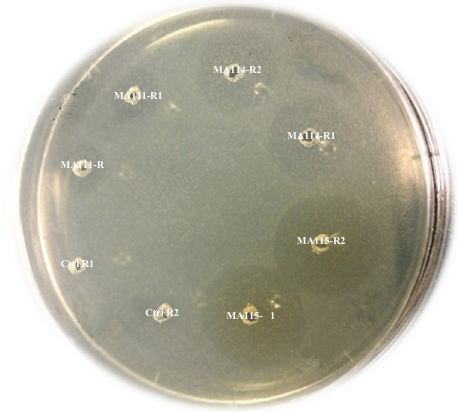
Figure 1: Inhibition zones of CFSn extracted from three LAB strains on the surface of MH agar plate layered with L. monocytogenes using the agar well di ff usion assay after incubation at 37°C for 24 h. The CFSn of three LAB isolates with anti - listerial activity: isolate MA115, isolate MA114, and isolate MA111, and sterilized MRS broth as control ( Ctrl ) . R1 and R2 are replicates of each